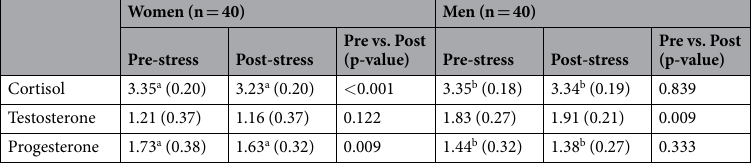
Table 1. Mean (standard deviation) of cortisol, testosterone and progesterone (pg/ml, log-transformed) before (pre-stress) and 25 minutes after stress onset (post-stress) as well as p-values for the comparison (pre vs. post) are listed. Note. a n = 39, b n = 38.